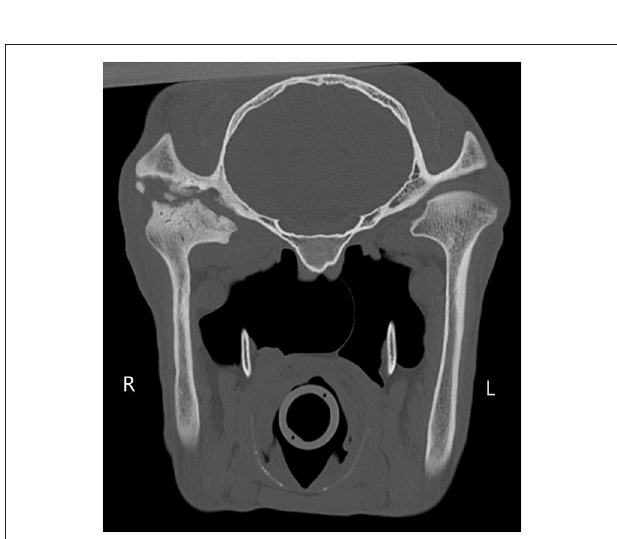
FIGURE 2 | The right temporomandibular joint is widened. There is a large amount of multifocal lysis of the articular margins of the condylar process of the right mandible and right temporal bone, and to a lesser extent of the ventral aspect of the right zygomatic arch. There are multiple round osseous fragments surrounded by regions of hypoattenuation of the right temporal bone.